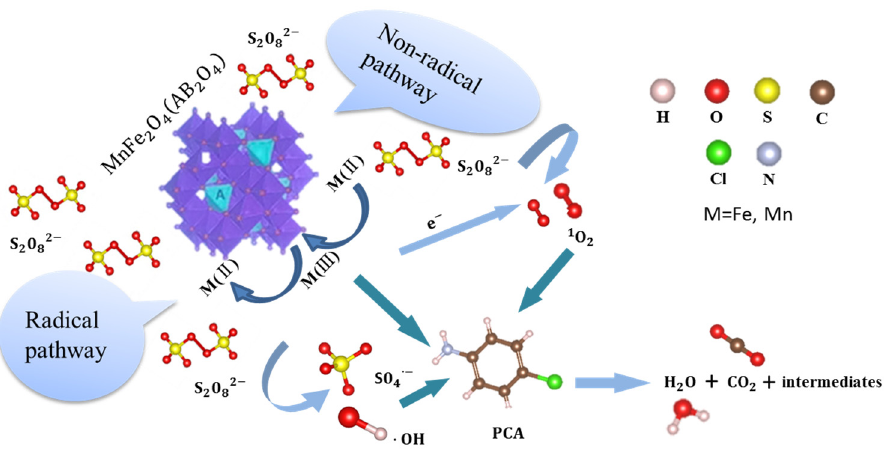
Figure 10. Schematic representation of the possible degradation mechanism of PCA in the MnFe 2 O 4 /PDS